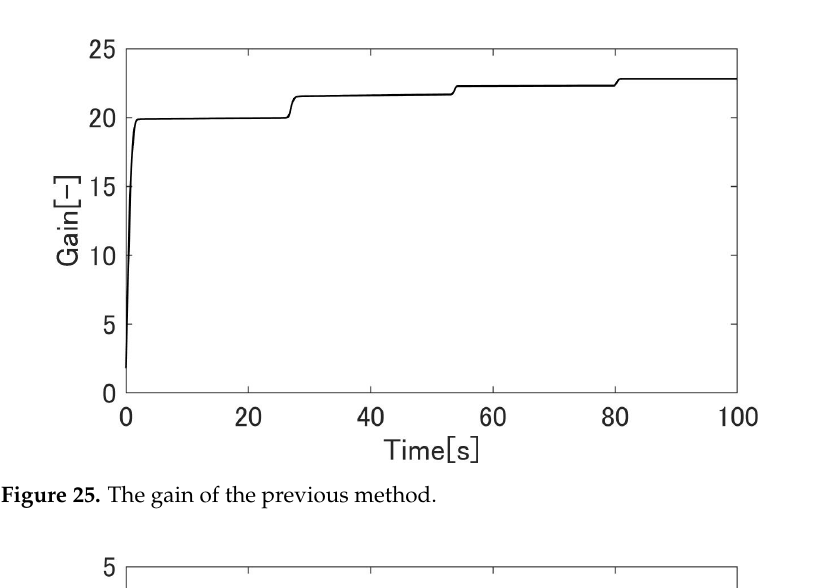
Figure 24. The comparison of output angles θ .